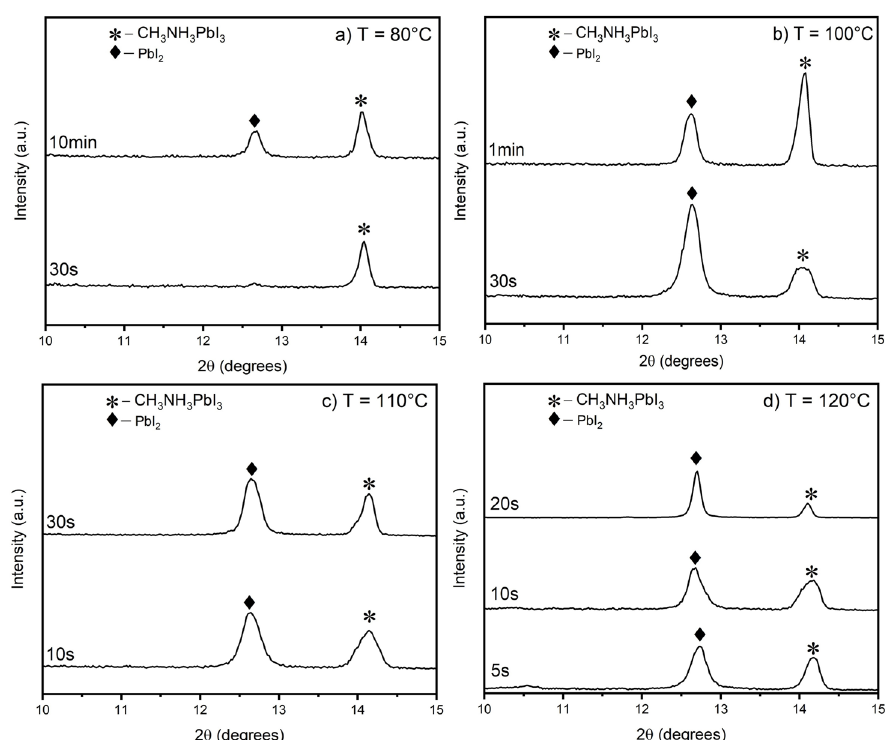
Figure 6. XRD patterns of the treated perovskite 50-day films fabricated via spray deposition at different temperatures and annealing times: a) 80 o C; b) 100 o C; c) 110 o C; d) 120 o